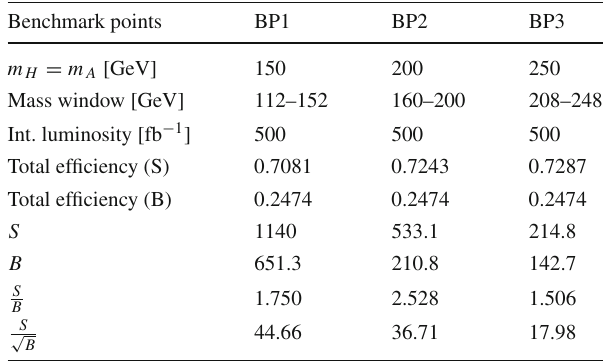
mark point. Any value of m 2 to the same branching ratio of Higgs boson decay to b tan β < 50. Therefore the signal significance values obtained for tan β = 10 are valid up to tan β (cid:6) 50 provided that for each value of tan β , the allowed value of m 2 the range provided in Fig.